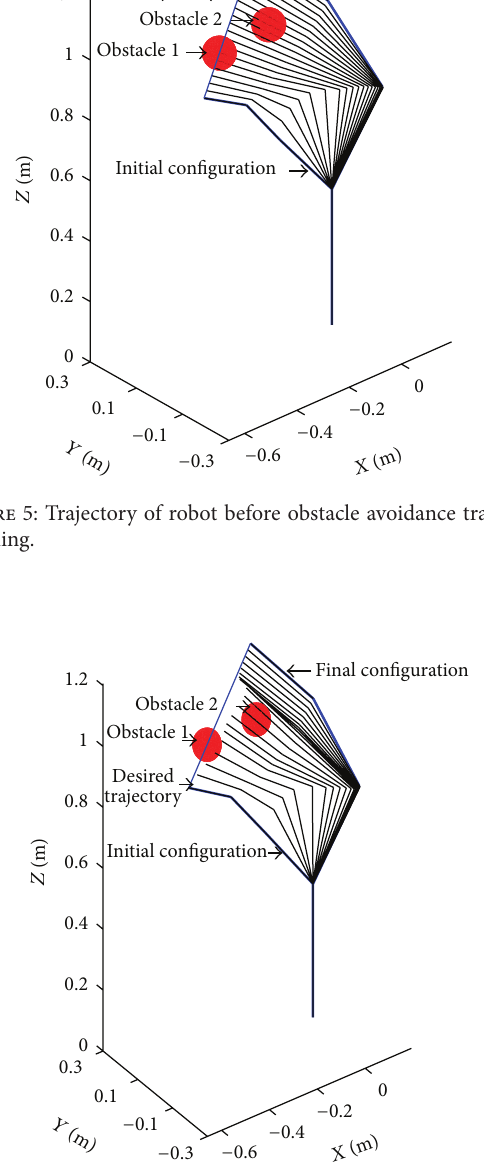
Figure 6: Trajectory for obstacle avoidance using the approach based on transitioning between